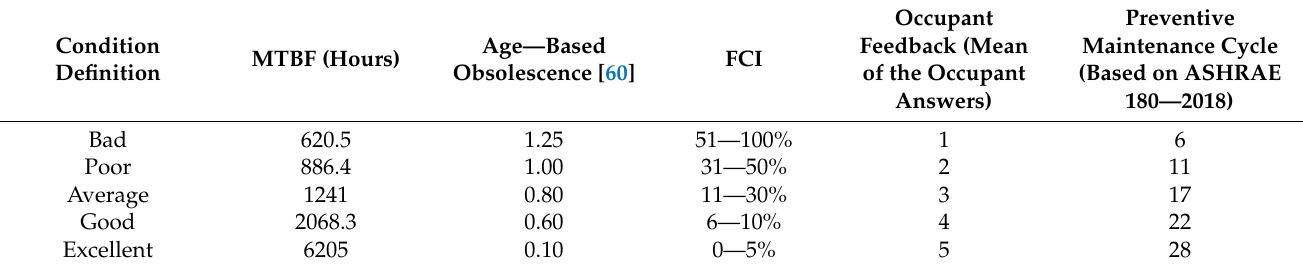
Table 3. The values best corresponding to condition definitions for each